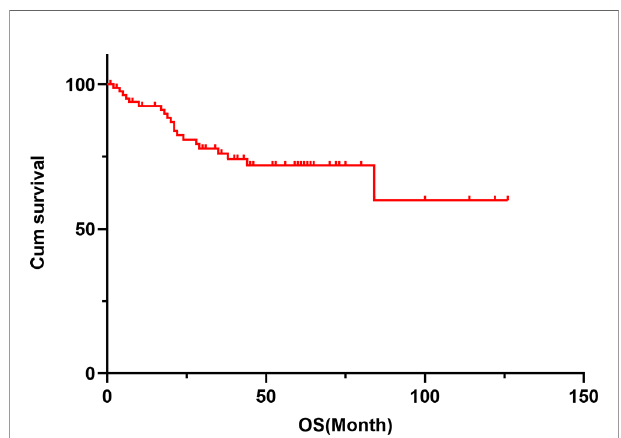
FIGURE 1 | The cumulative survival curve of patients with TETs. The 1- year survival rate was 92.6%, the 3-year survival rate was 76.0%, and the 5- year survival rate was 71.9% in patients with TETs.